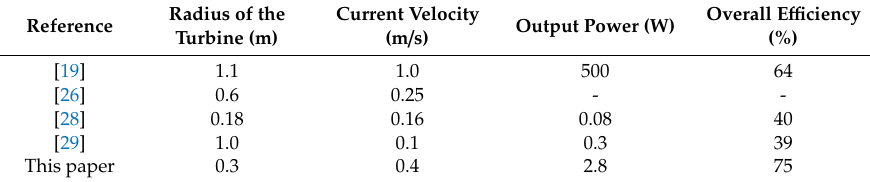
Table 1. Comparison between previous studies and the proposed low-velocity ocean current energy harvester